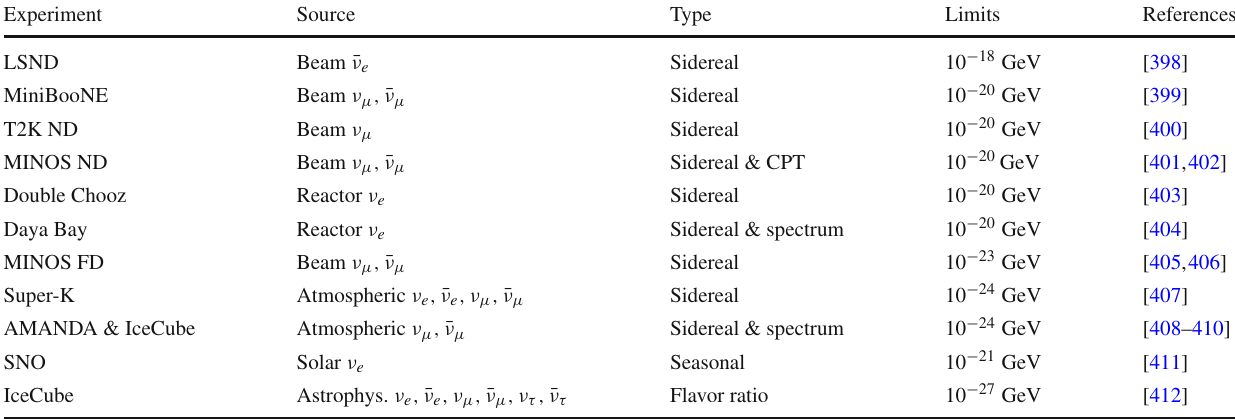
Table 4 Limits on SME coefficients obtained from neutrino experi- ments. Four types of tests are performed, including sidereal-variation searches in the oscillation signals (sidereal), spectrum distortions due to Lorentz-violating neutrino oscillations or mixings (spectrum), seasonal variations of Lorentz-violating solar mixings (seasonal), and searches for anomalous astrophysical neutrino flavor ratios (flavor ratio). Quoted